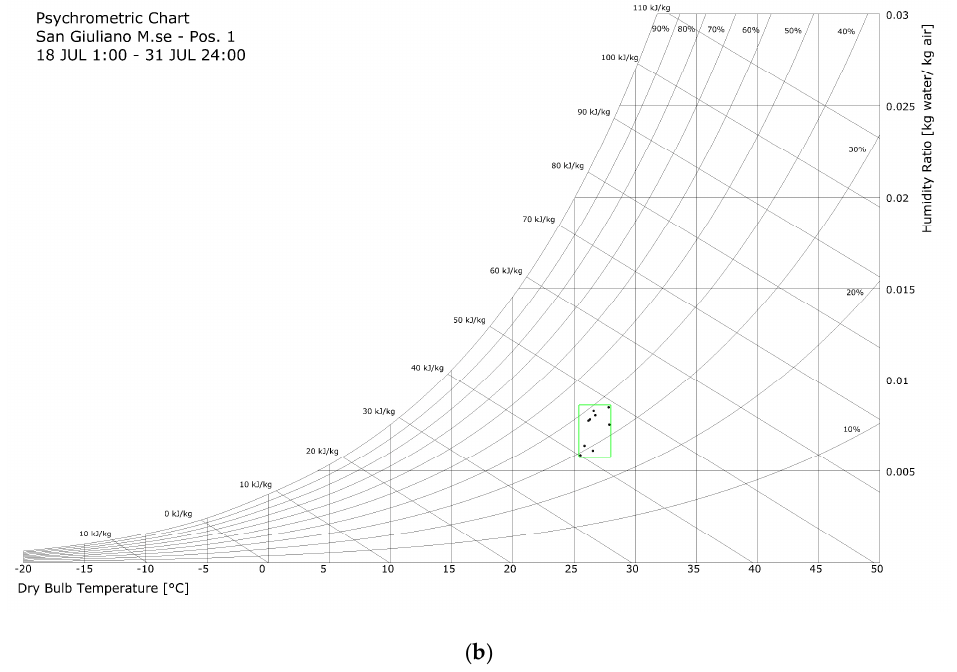
Figure 4. GCZM for Pos. 1: ( a ) based on standard approach; ( b ) based on TSV